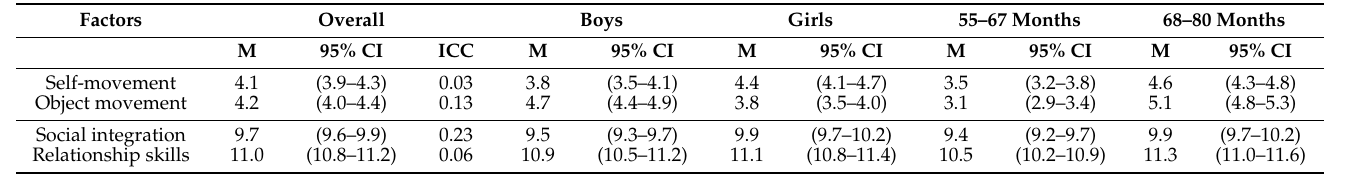
Table 2. Descriptive sum values of the motor competency domains (0–8), social integration (0–12), and interpersonal relationship skills (0–16) by gender and age groups. ICC: interclass